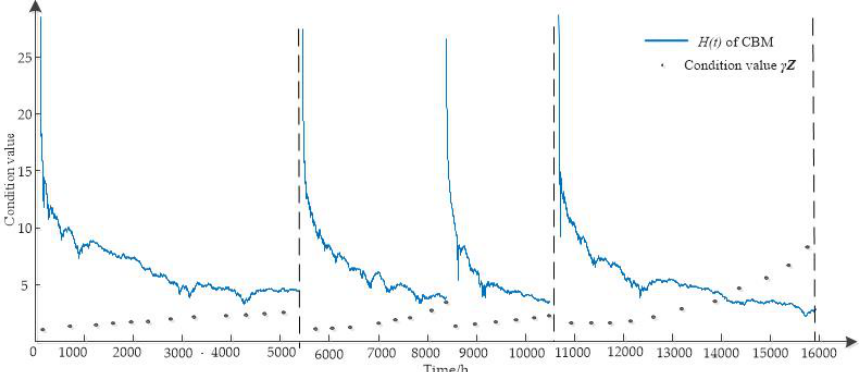
Fig. 7. Maintenance strategy of combining TBM and